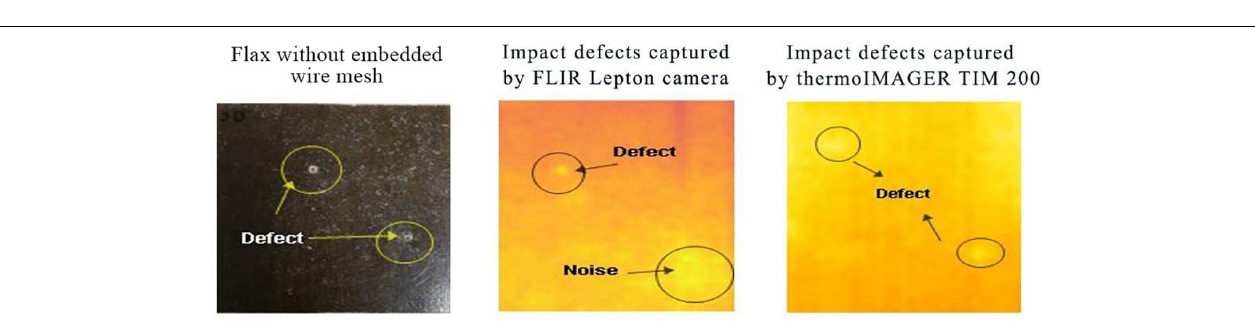
FIGURE 9 | Impact defect images captured by FLIR Lepton and thermoIMAGER TIM200 infrared